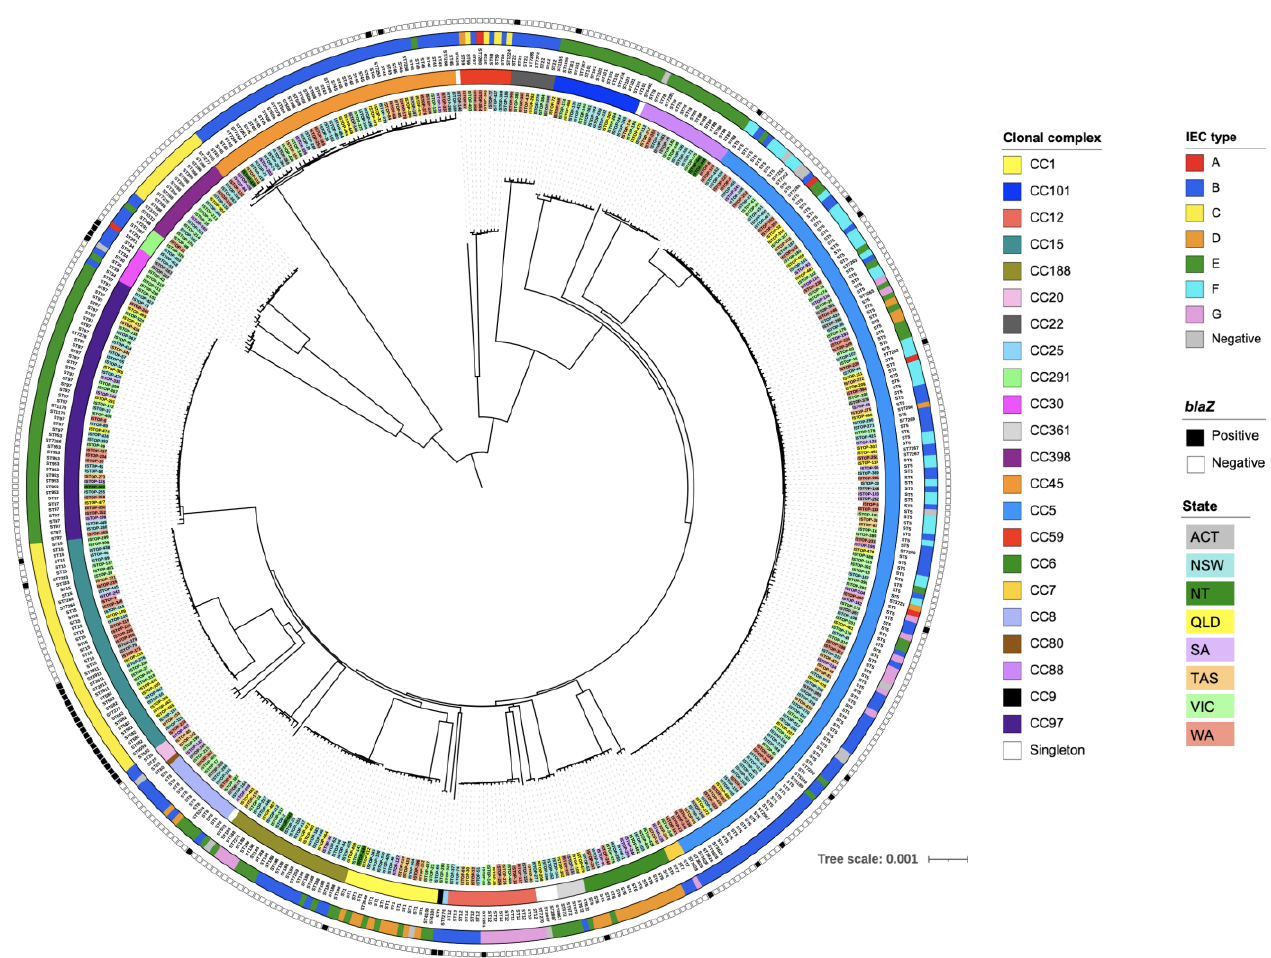
Figure 2. Phylogenetic tree of 470 MSSA isolates causing bacteremia in Australia during 2020 classified as penicillin-susceptible by Vitek ® 2. The branch tips are labelled with the sample ID. The branch labels are highlighted in different colors, each representing the state or territory from which the isolates were collected. Data on the clonal complex (inner circle), sequence type (labels), IEC type (outer circle), and presence of the blaZ gene (square symbols) are overlaid on the tree. CC, clonal complex; ST, sequence type; IEC, immune evasion cluster; ACT, Australian Capital Territory; NSW, New South Wales; NT, Northern Territory; QLD, Queensland; SA, South Australia; TAS, Tasmania; VIC, Victoria; WA, Western Australia. The tree was constructed using single nucleotide polymorphisms from the core genome alignment of the PSSA